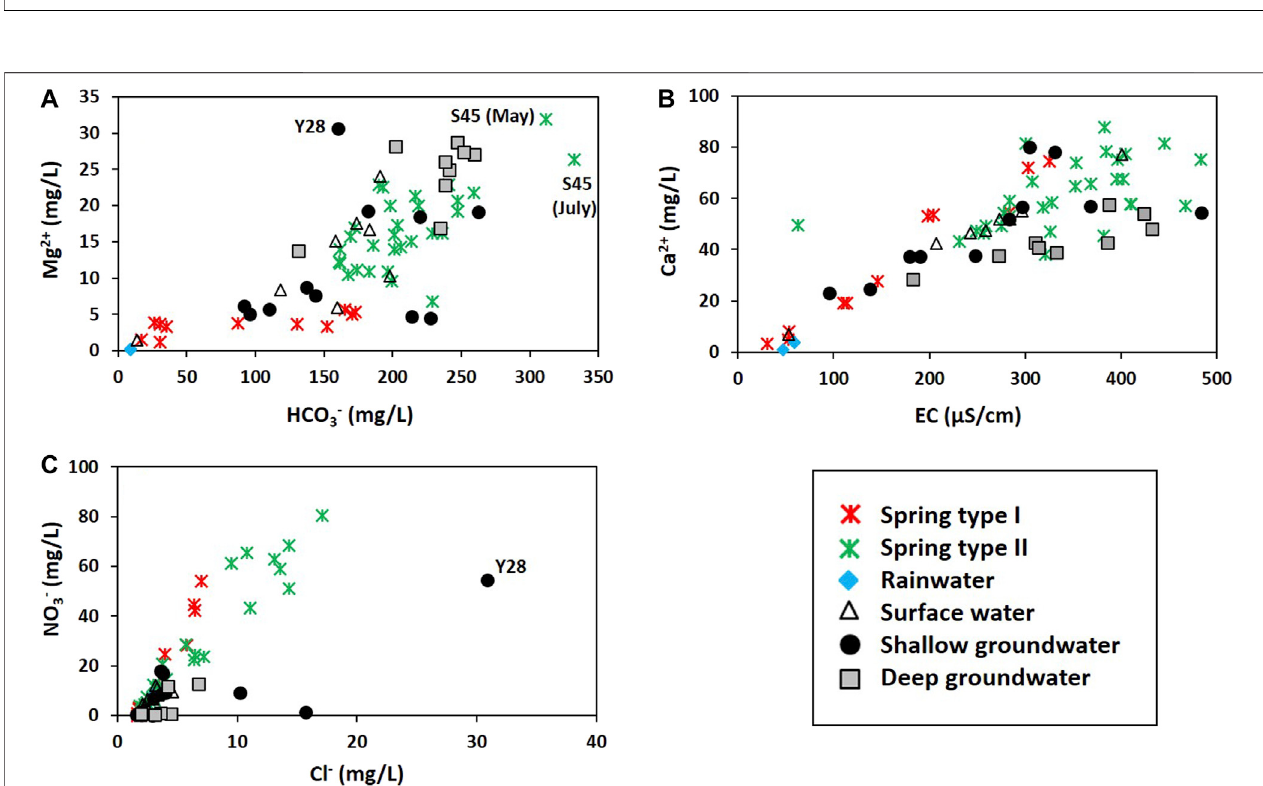
FIGURE4| Comparison ofconcentrations: (A) Mg 2+ vs. HCO 3 − ; (B) Ca 2+ vs. EC; (C) NO 3 − vs. Cl − .In (A) and (C) ,theletters indicate thenameofdistinct samples.